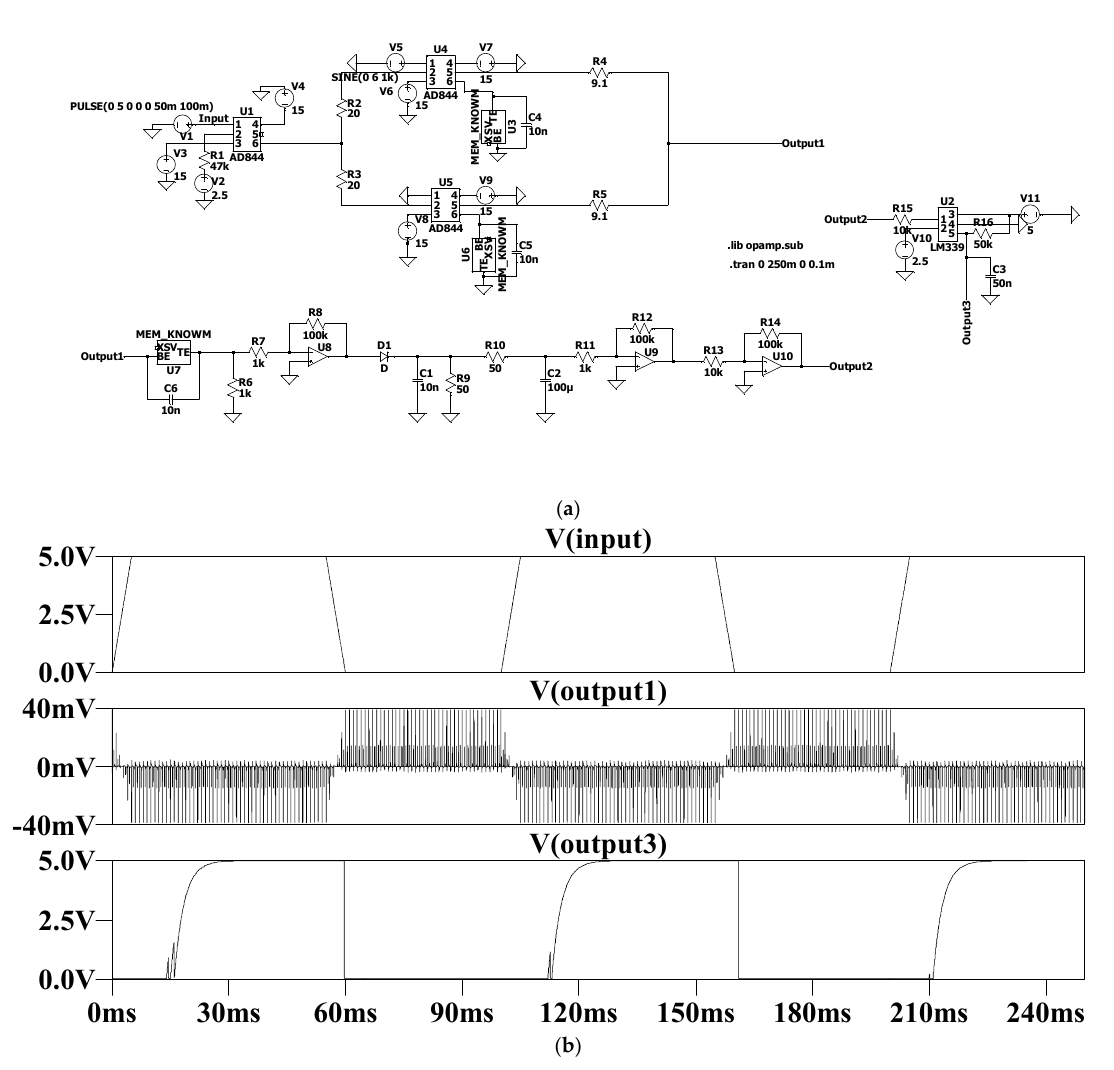
Figure 7. Simulation circuit and waveform. ( a ) Time domain simulation circuit diagram of modulator/demodulator. ( b ) The simulation results.